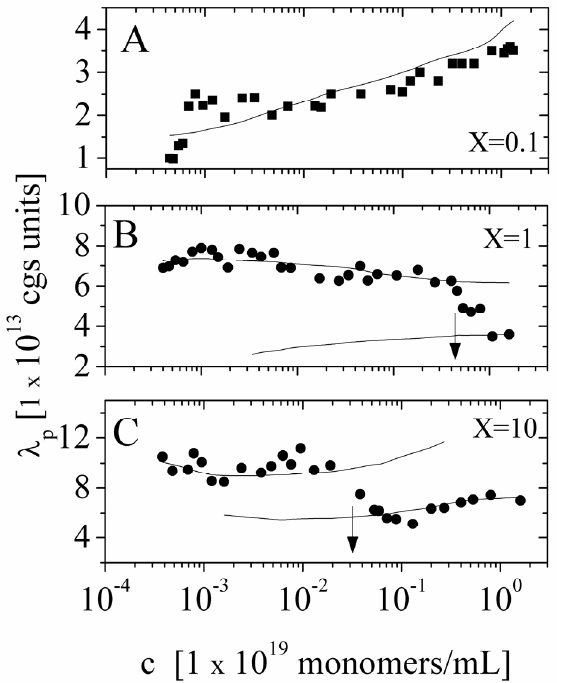
Figure 7. The equivalent conductance of NaPAA polyions in aqueous solutions in the presence of added salt ( X = 0.1, X = 1, X = 10) as a function of the polyion concentration. Polymer in good solvent condition. Panel ( A ) Dilute solution, X = 0.1; ( ■ ) experimental values derived from the measured electrical conductivity. Full curve is calculated on the basis of Equation (5.2.1). Panel ( B ) Dilute and semidilute solution, the transition region being marked by the arrow, X = 1; ( ) experimental values derived from the measured electrical conductivity. Upper full curve is calculated on the basis of Equation (5.2.1) in the dilute regime and lower full curve calculated on the basis of Equation (5.2.2) in the semidilute regime. Panel ( C ) Dilute and semidilute solution, the transition region being marked by the arrow. X = 10; ( ) experimental values derived from the measured electrical conductivity. Upper full curve is calculated on the basis of Equation (5.2.1) in the dilute regime and lower full curve calculated on the basis of Equation (5.2.2) in the semidilute regime. Data redrawn from Reference